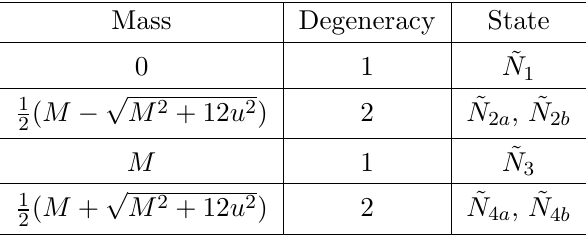
. The masses M and u are de(cid:12)ned N